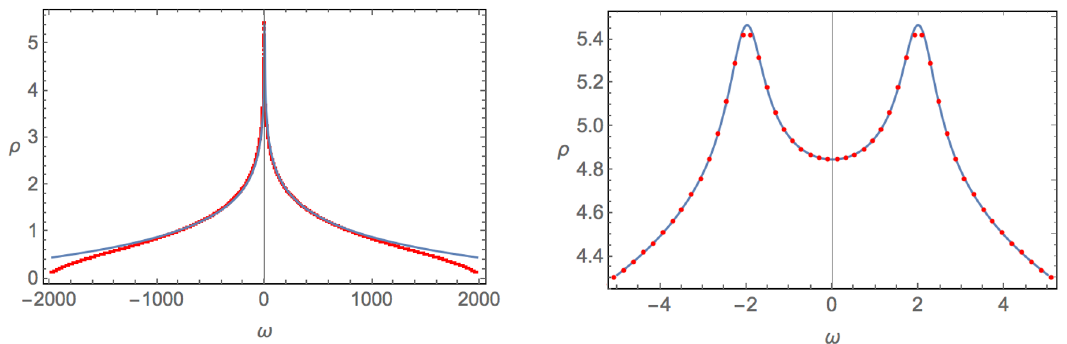
+ iν scalar with ν = 2 in dS . The red dots show the local Figure 11 . Density of states for a ∆ = 1 2 2 eigenvalue density ¯ ρ ( ω ) , (B.10), of the truncated model with global angular momentum cutoff N N = 2000 , obtained by numerical diagonalization. The blue line shows ρ ( ω ) obtained as the Fourier transform of χ ( t ) , explicitly (B.8) with e − γ Λ ≈ 4000 . The plot on the right zooms in on the IR region. The peaks are due to the proximity of quasinormal mode poles in ρ ( ω ) , discussed in